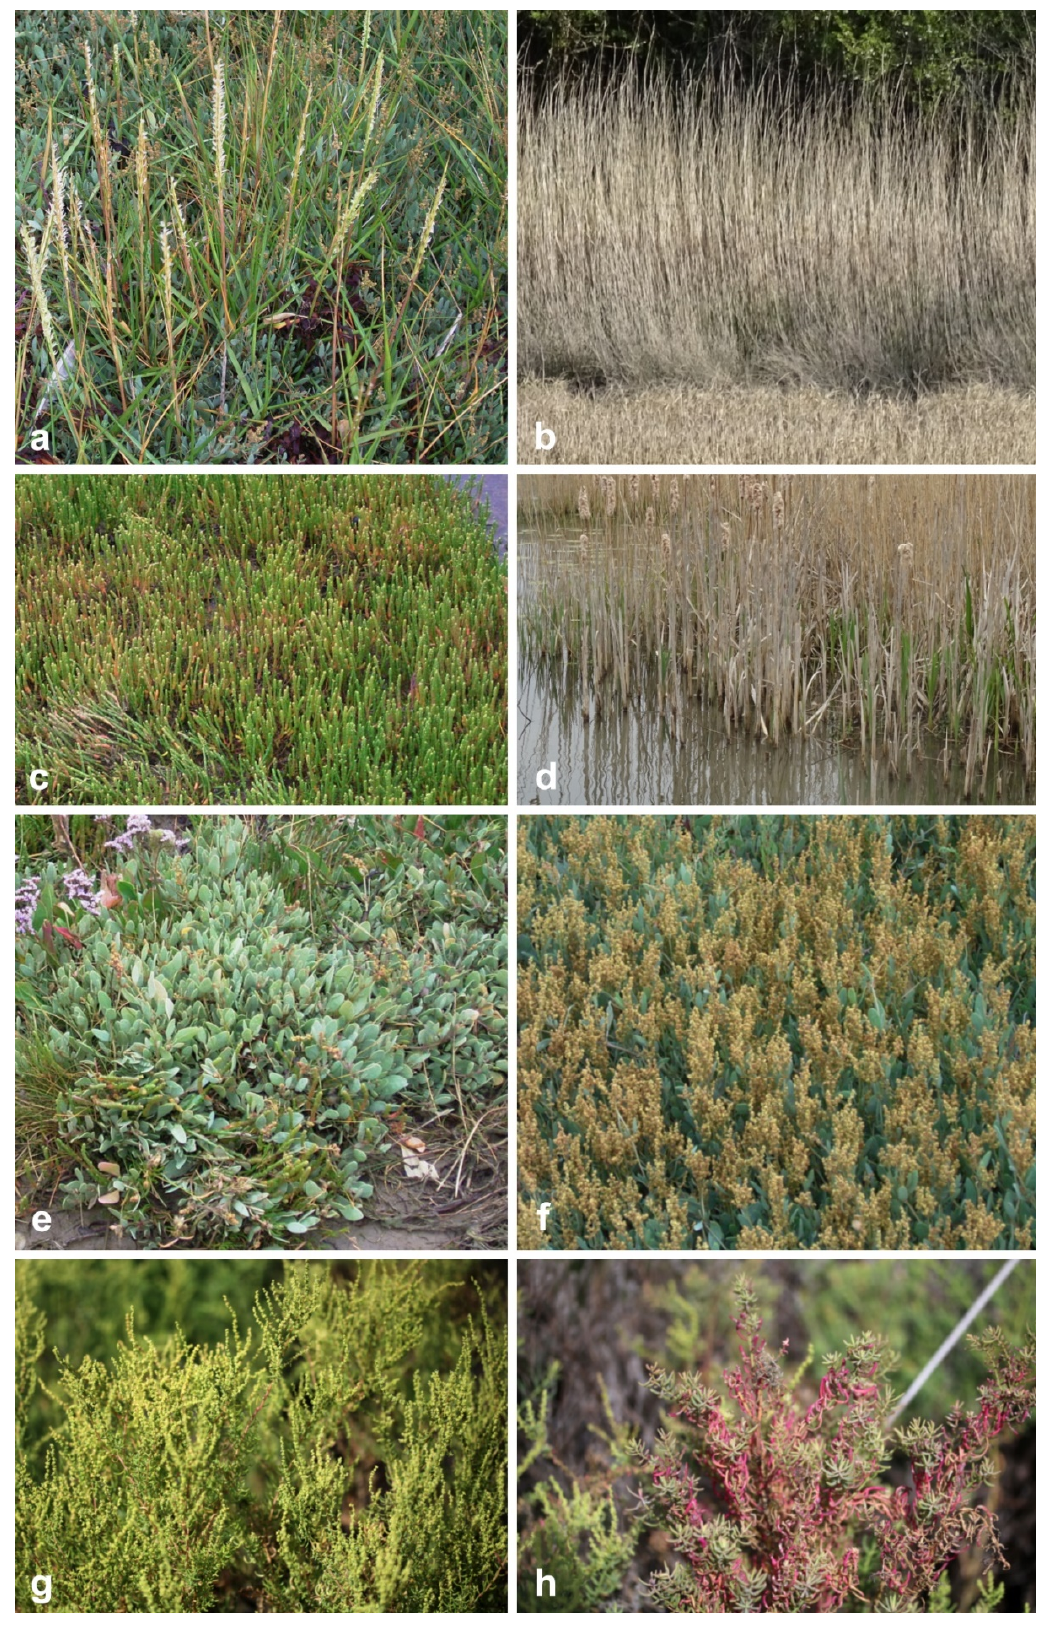
Figure 2. Halophytes in salt marsh ecosystems: ( a ) flowering inflorescence of Spartina , ( b ) Phragmites , ( c ) Salicornia, ( d ) Typha , ( e , f ) Atriplex , and ( g , h ) Suaeda.